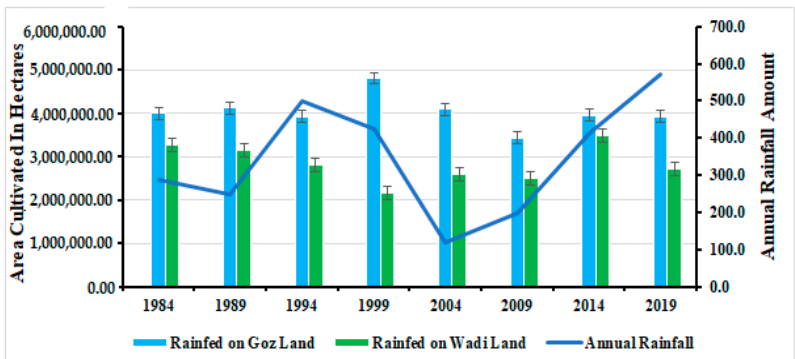
Figure 6. Compare area coverage by rainfed agriculture on goz land (RG) and on wadi lands (RW) and mean annual rainfall from 1984 to